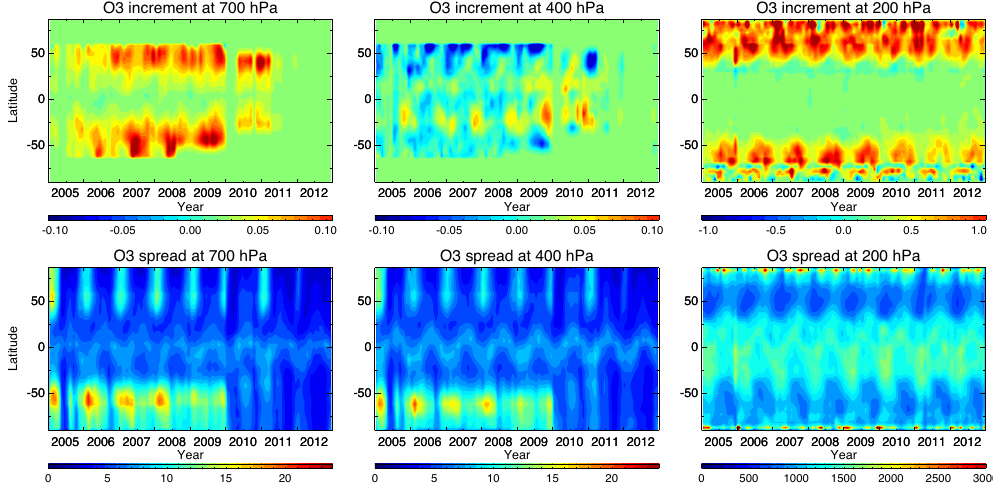
Figure 3. Time–latitude cross section of the analysis increment (upper panels, in ppb per analysis step) and the analysis spread (lower panels, in ppb/analysis step) obtained for O 3 at 700hPa (left), 400hPa (centre), and 200hPa